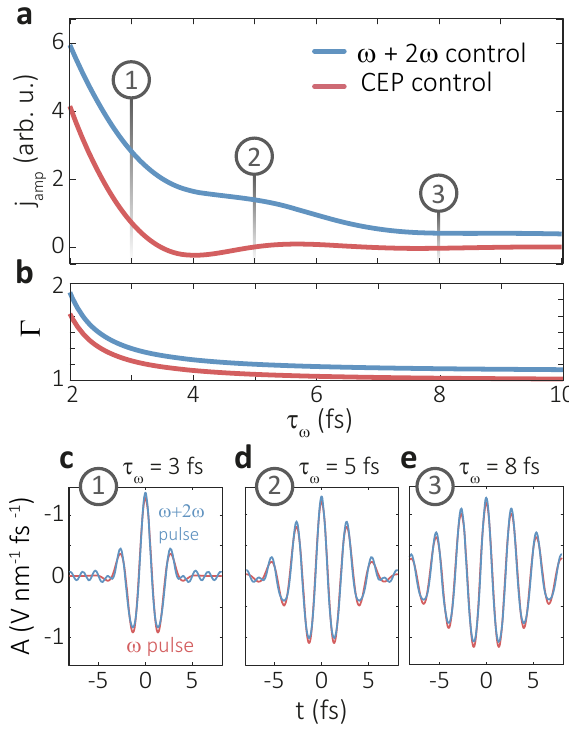
Figure 3: Residual current as a function of pulse duration obtained from TDSE simulations. (a) Residual current induced by a Gaussian = 2 . 8 V/nm, laser pulse centered at 𝜔 = 2 𝜋 ⋅ 375 THz, E 0 ,𝜔 Φ = 𝜋 ∕ 2 (red line). For 𝜔 + 2 𝜔 control (blue line) a Gaussian CEP pulse centered at 2 𝜔 = 2 𝜋 ⋅ 750 THz with the same CEP and E 0 , 2 𝜔 = 0 . 3 V/nm is admixed. In both cases, the pulse duration 𝜏 𝜔 of the fundamental ( 𝜔 ) is swept from 2 fs to 10 fs. (b) Corresponding Γ parameter for both schemes. (c–e) Vector potential of the 𝜔 -pulse and the 𝜔 + 2 𝜔 pulse for 𝜏 𝜔 = 3 , 5 , 8 fs, see marks in (a).